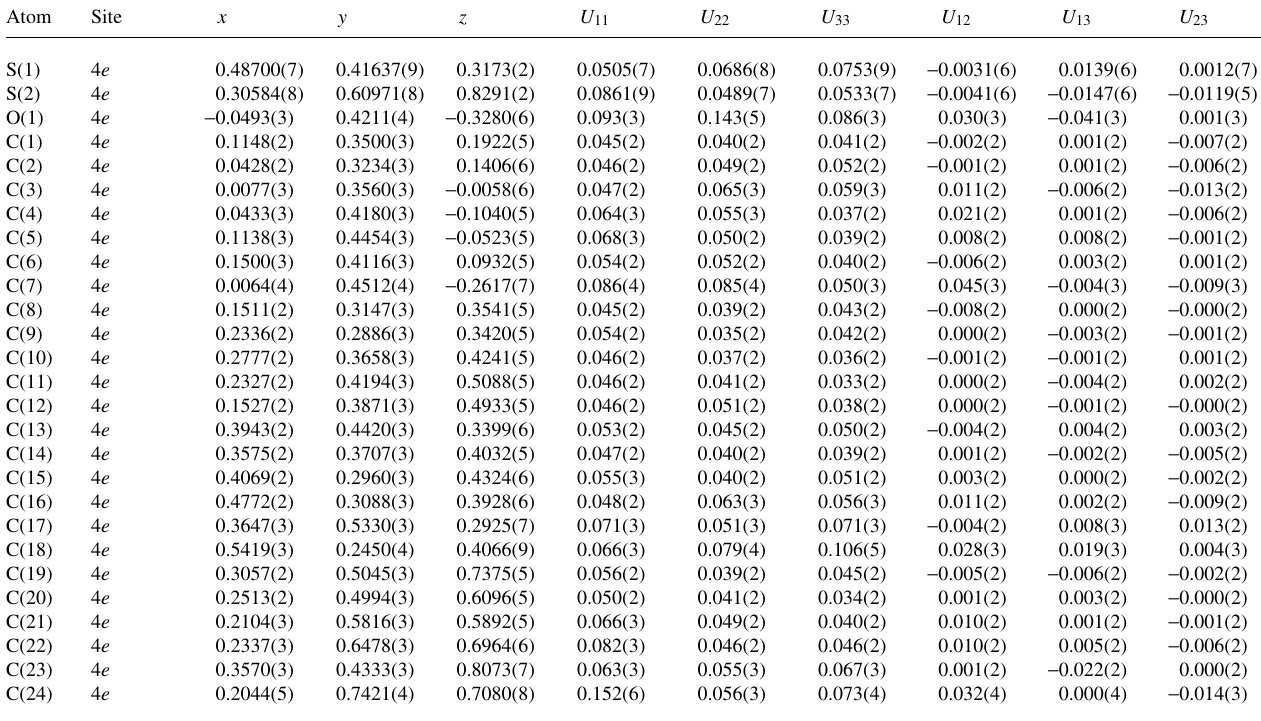
Table 3. Atomic coordinates and displacement parameters (in Å 2 ) .